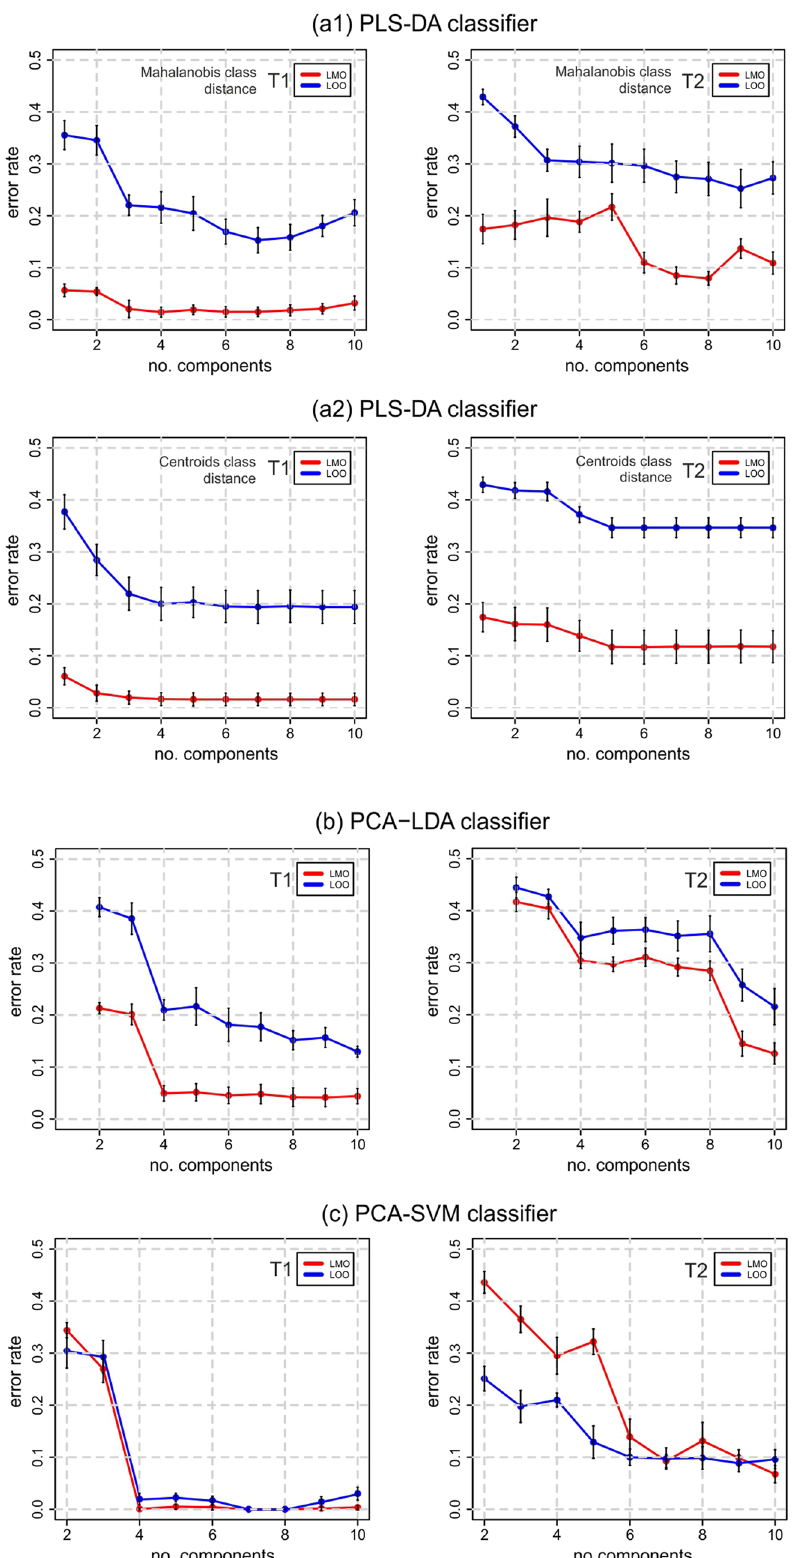
Figure 4. Mean error rates for pilling grade prediction. LOO—Leave-one-out validation, LMO—Leave-mean- out validation. In the case of the PLS-DA classifier, two methods of measuring the distance to the centroids of the pilling classes were tested: ( a1 ) Mahalanobis distance and ( a2 ) centroid